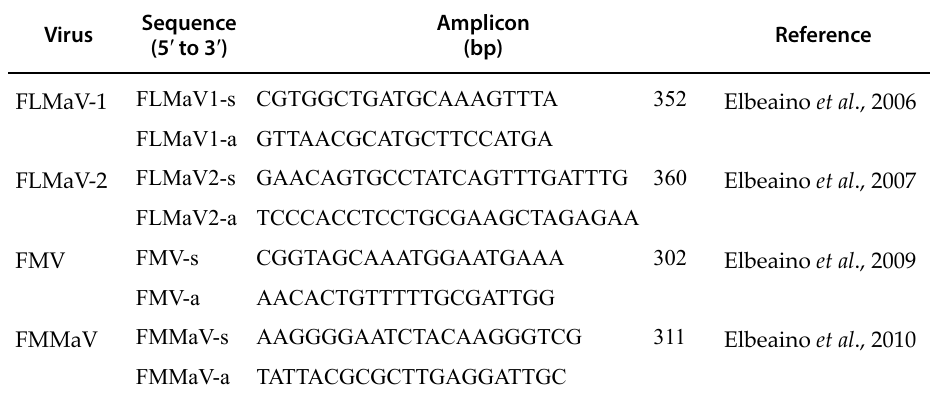
Table 1. RT-PCR specific primers of four fig-infecting viruses (FLMaV-1, FLMaV-2, FMMaV and FMV).